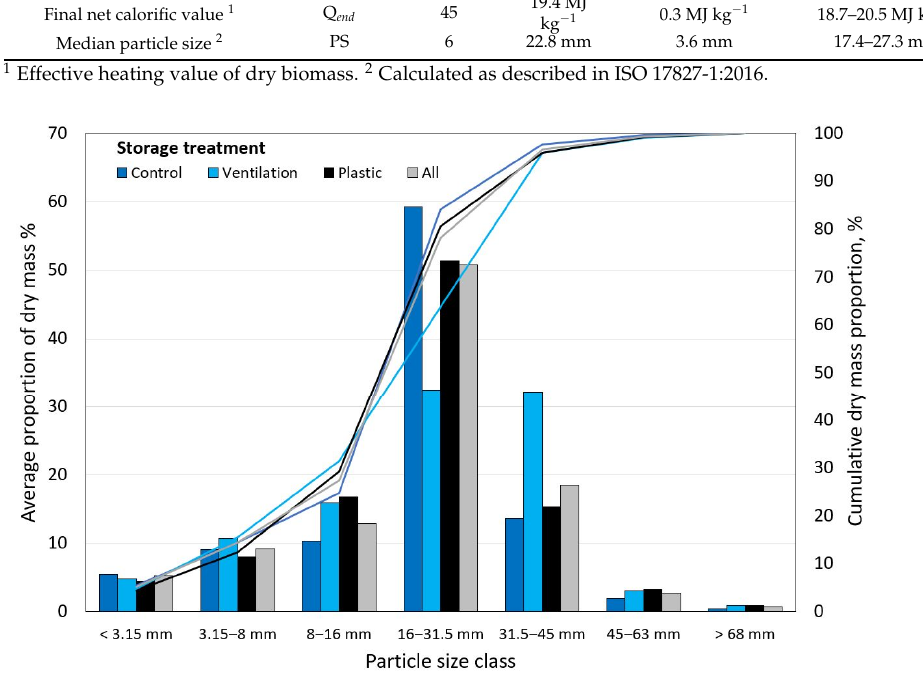
Figure 4. Initial particle size distributions by storage treatment.